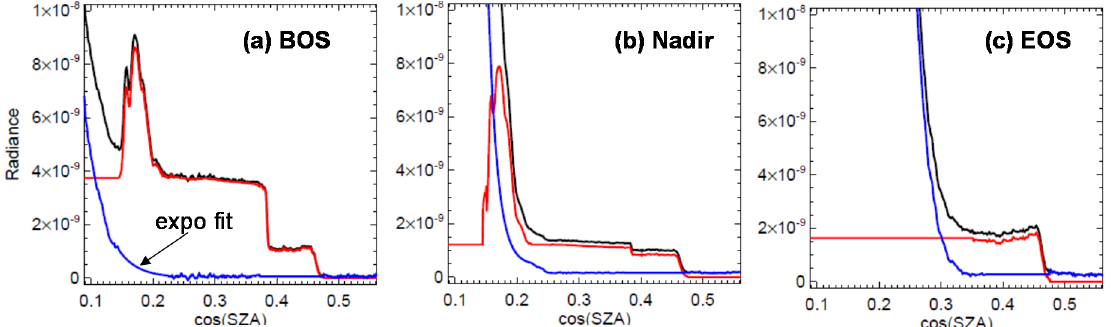
Figure 10. DNB EV dark signals near the southern hemisphere stray light problem regions on October 5, 2013. ( a – c ) show EV dark signals for beginning of scan (BOS), nadir, and end of scan (EOS), respectively. Black curves are computed dark signals, red curves are estimated stray light based on the updated method, and blue curves are the signals after stray light correction. SZA = solar zenith angle.